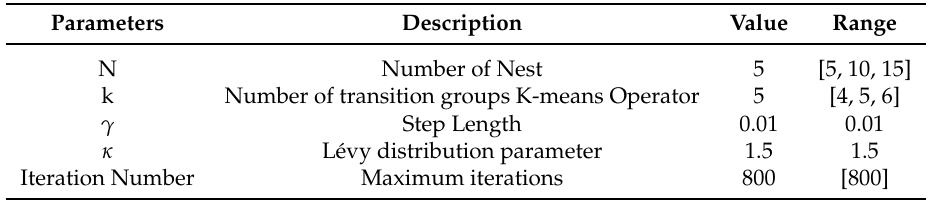
Table 4. Parameter setting for the Cuckoo search algorithm.